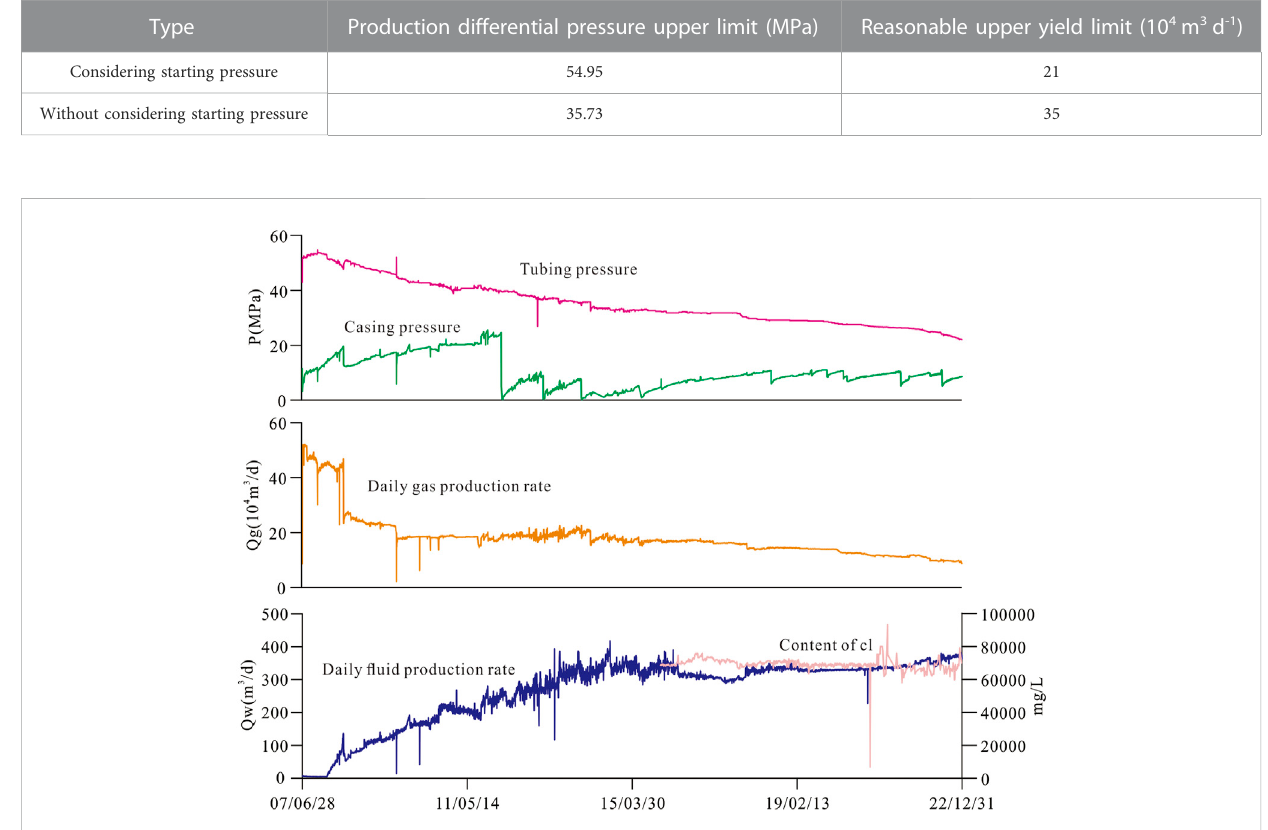
FIGURE 6 Production curve of typical wells in a deep tight gas reservoir in western